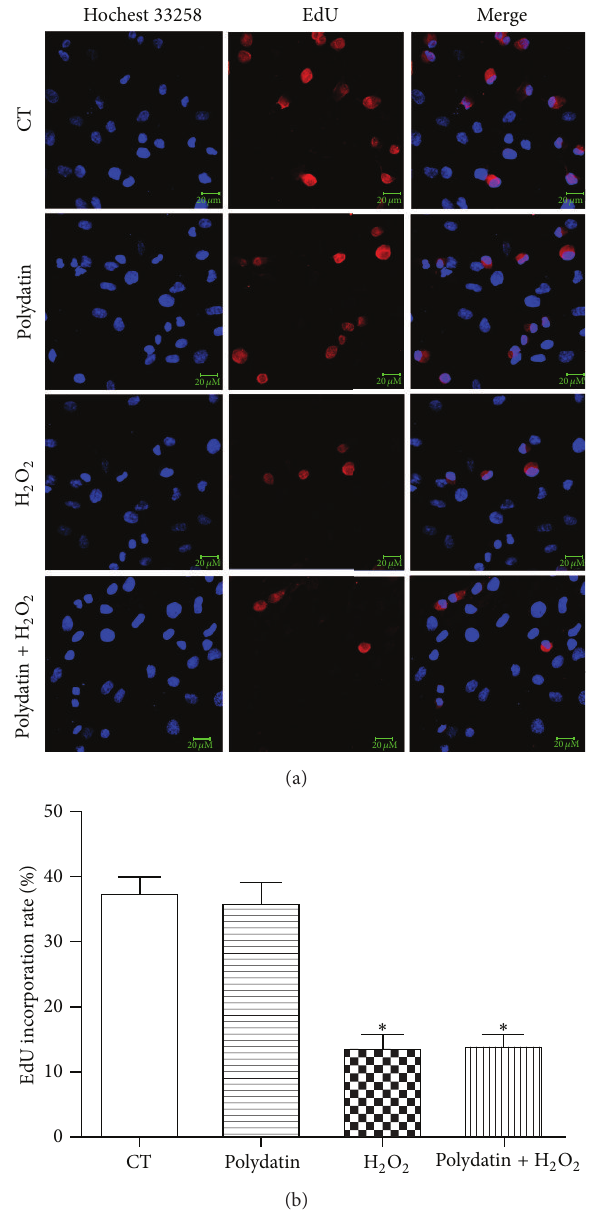
Figure 5: Polydatin did not inhibit the proliferation of BMSCs. (a) Proliferation rate of BMSCs was detected by EdU and Hochest 33258 staining. Fluorescence was visualized by a laser-scanning confocal microscope. Scale bar represents 20 𝜇 M. (b) Quantitative analysis of the EdU incorporation rate of BMSCs. ∗ 𝑝 < 0.05 versus control